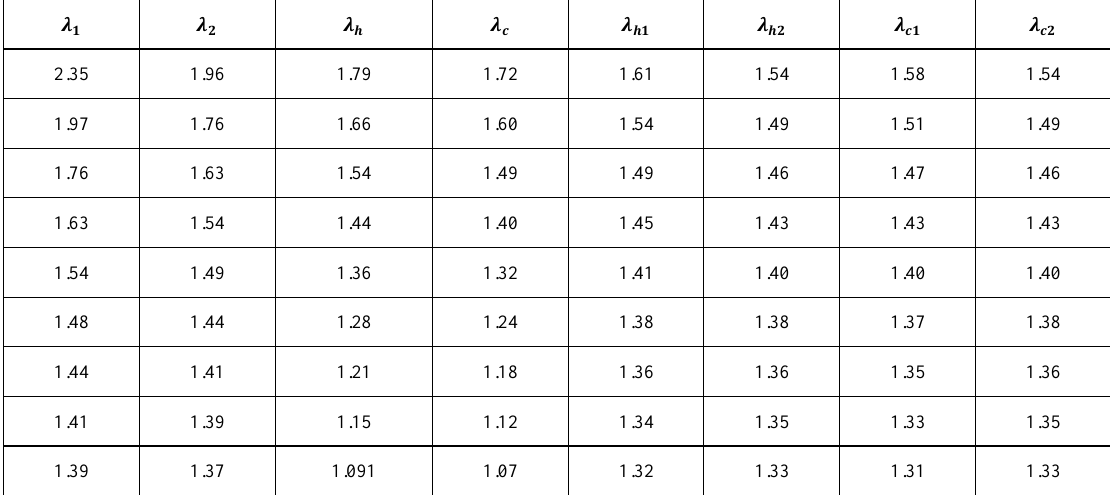
Table 3. MTTF as function of failure rates in the Comprehensive State